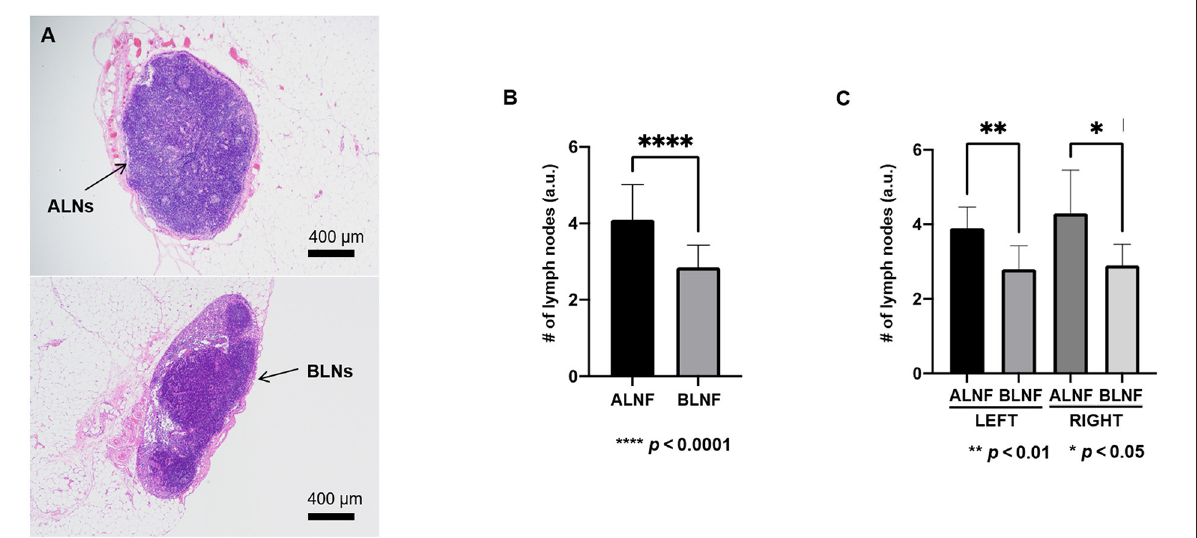
FIGURE6 (A) In the image magnified 40 × after H & E staining, the typical pathological image of axillary lymph nodes (ALNs) and brachial lymph nodes (BLNs) in the vascularized lymph node flap. (B) The number of lymph nodes in ALNF and BLNF. (C) The difference in the number of lymph nodes between the ipsilateral ALNF and BLNF is compared; the number of lymph nodes of the same type of LNFs on different sides is compared. ****, **, and * indicate the p-value between each groups (**** p < 0.0001, ** p < 0.01, * p <